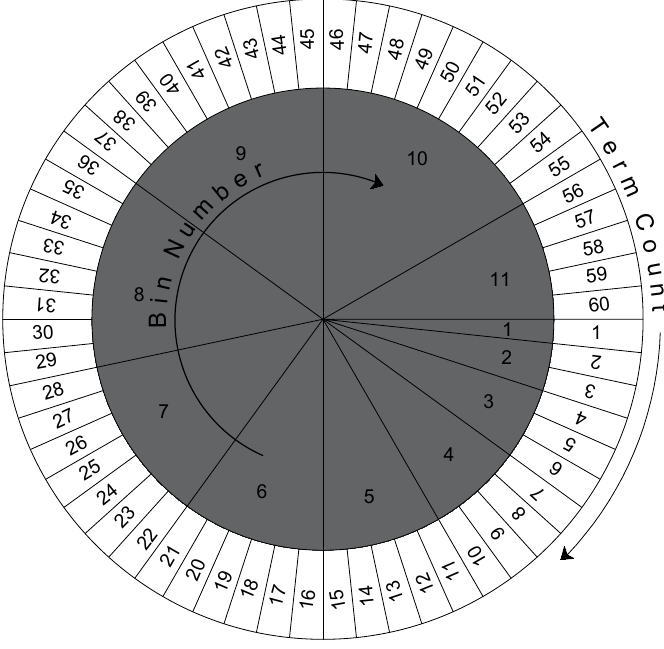
Figure 1. Mapping of term counts 1 to 60 to binned term